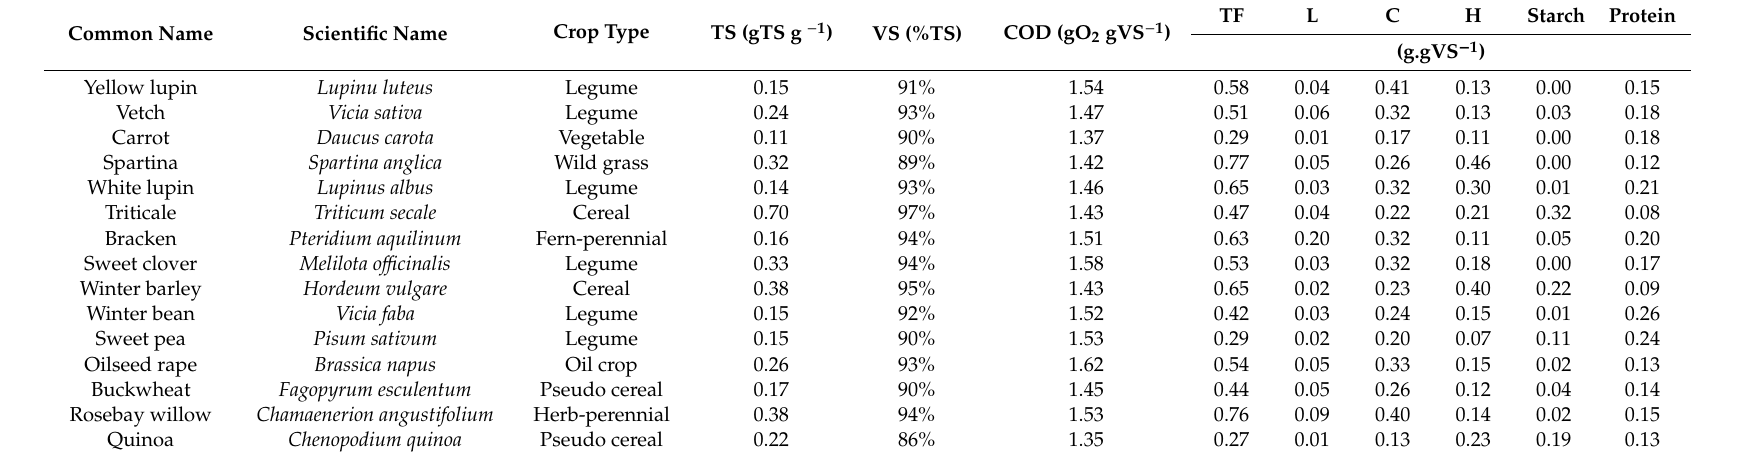
Table 1. Plant samples’